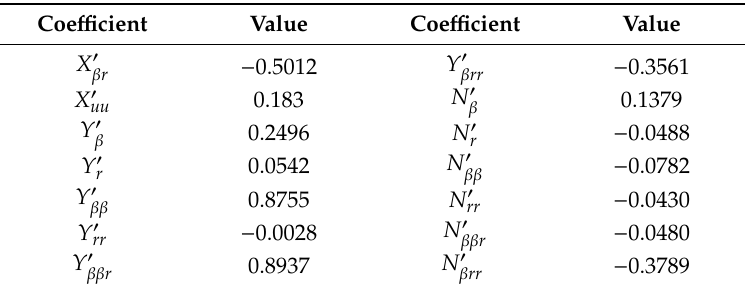
Table 2. The ship hydrodynamic coe ffi